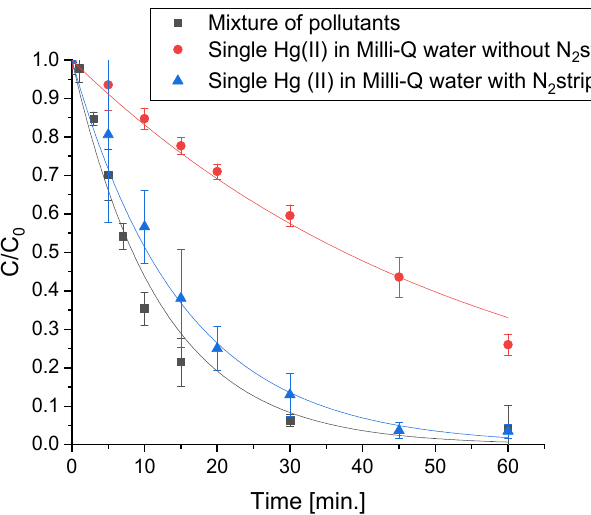
Figure 5. Hg(II) removal using ZCC in different working conditions.